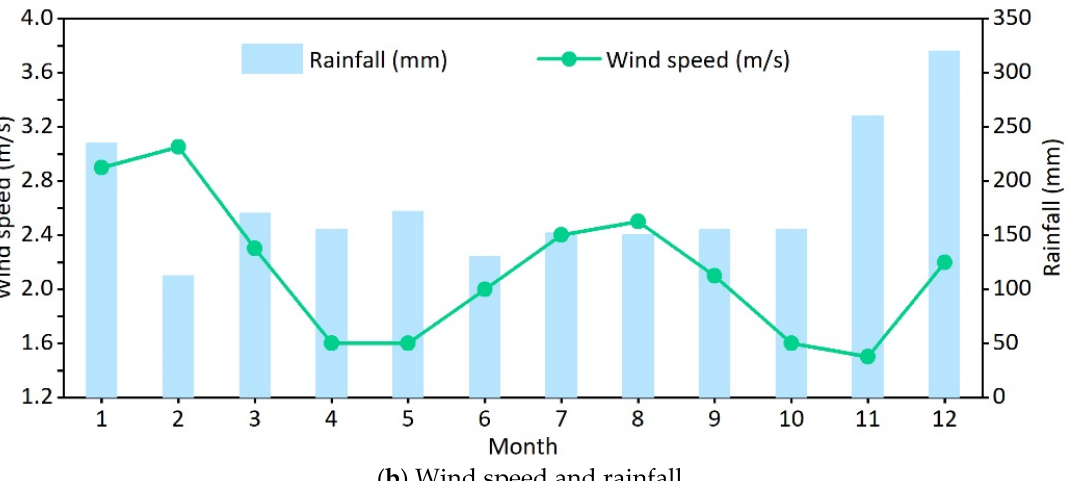
Figure 2. Monthly variations of meteorological variables in Singapore: ( a ) air temperature and sunshine hours; and ( b ) wind speed and rainfall.